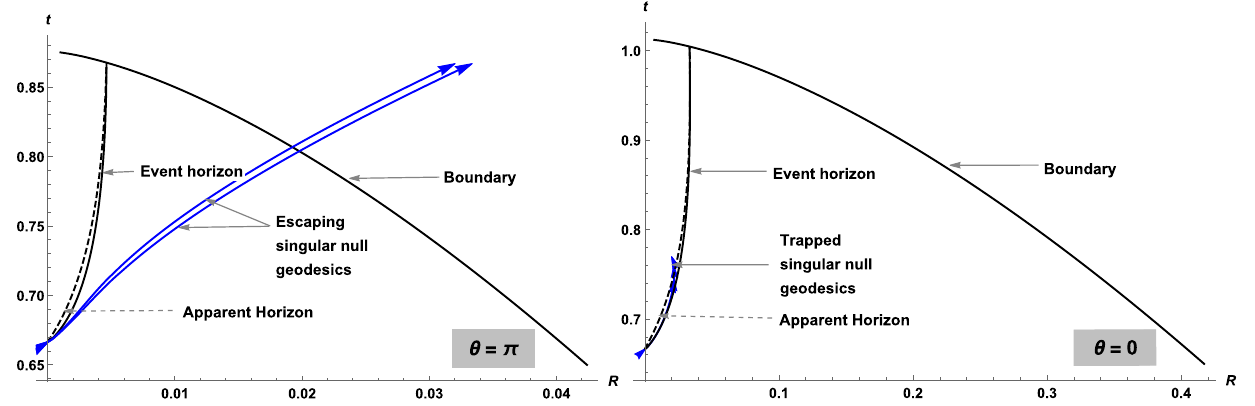
(cid:8) (cid:9) θ + exp ( − r ) f = − 10 − 3 r 2 and Q = exp ( r ) tan 2 . Escaping singular 2 4 null geodesics can reach the boundary of the collapsing cloud at θ = π , and these get trapped and fall back to the singularity at θ = 0. The singularity is thus directionally globally